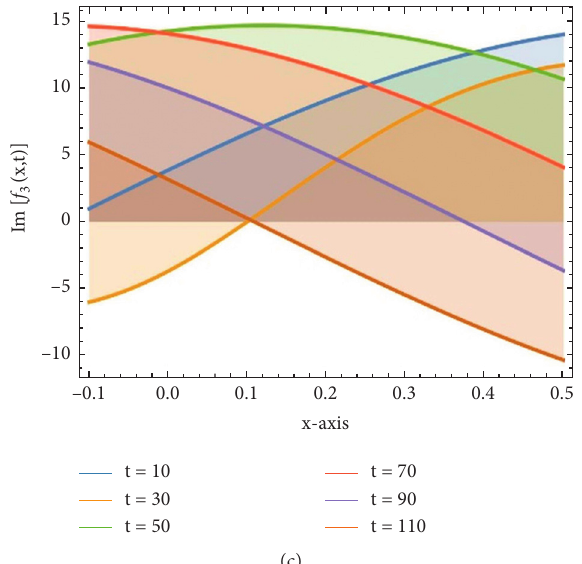
Figure 4: Optical soliton wave solutions of the absolute (a), real (b), and imaginary (c) value of equation (18) in two-dimensional view when � 1, A � − 2, a � 4, b � 5, b � − 1, and h � 2). ( A � 3, c 1 1 0 1